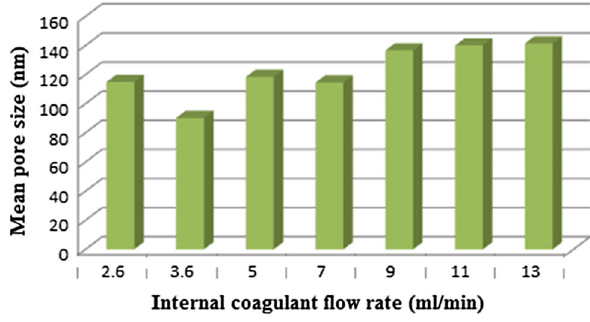
Fig. 6 Effect of ICFR on the mean pore size of the inner surface